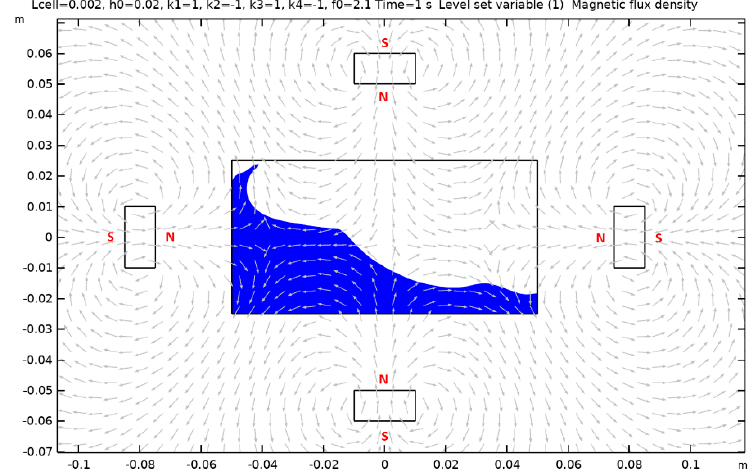
Figure A9. Case 10.